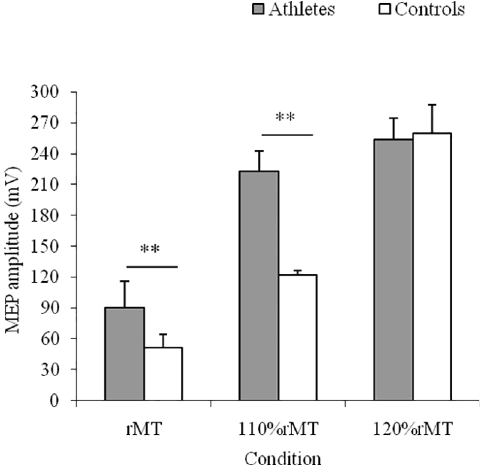
Fig 2. Motor Evoked Potential (MEP) Amplitude. Means and SDs of MEP amplitude in the three experimental conditions for karate athletes and